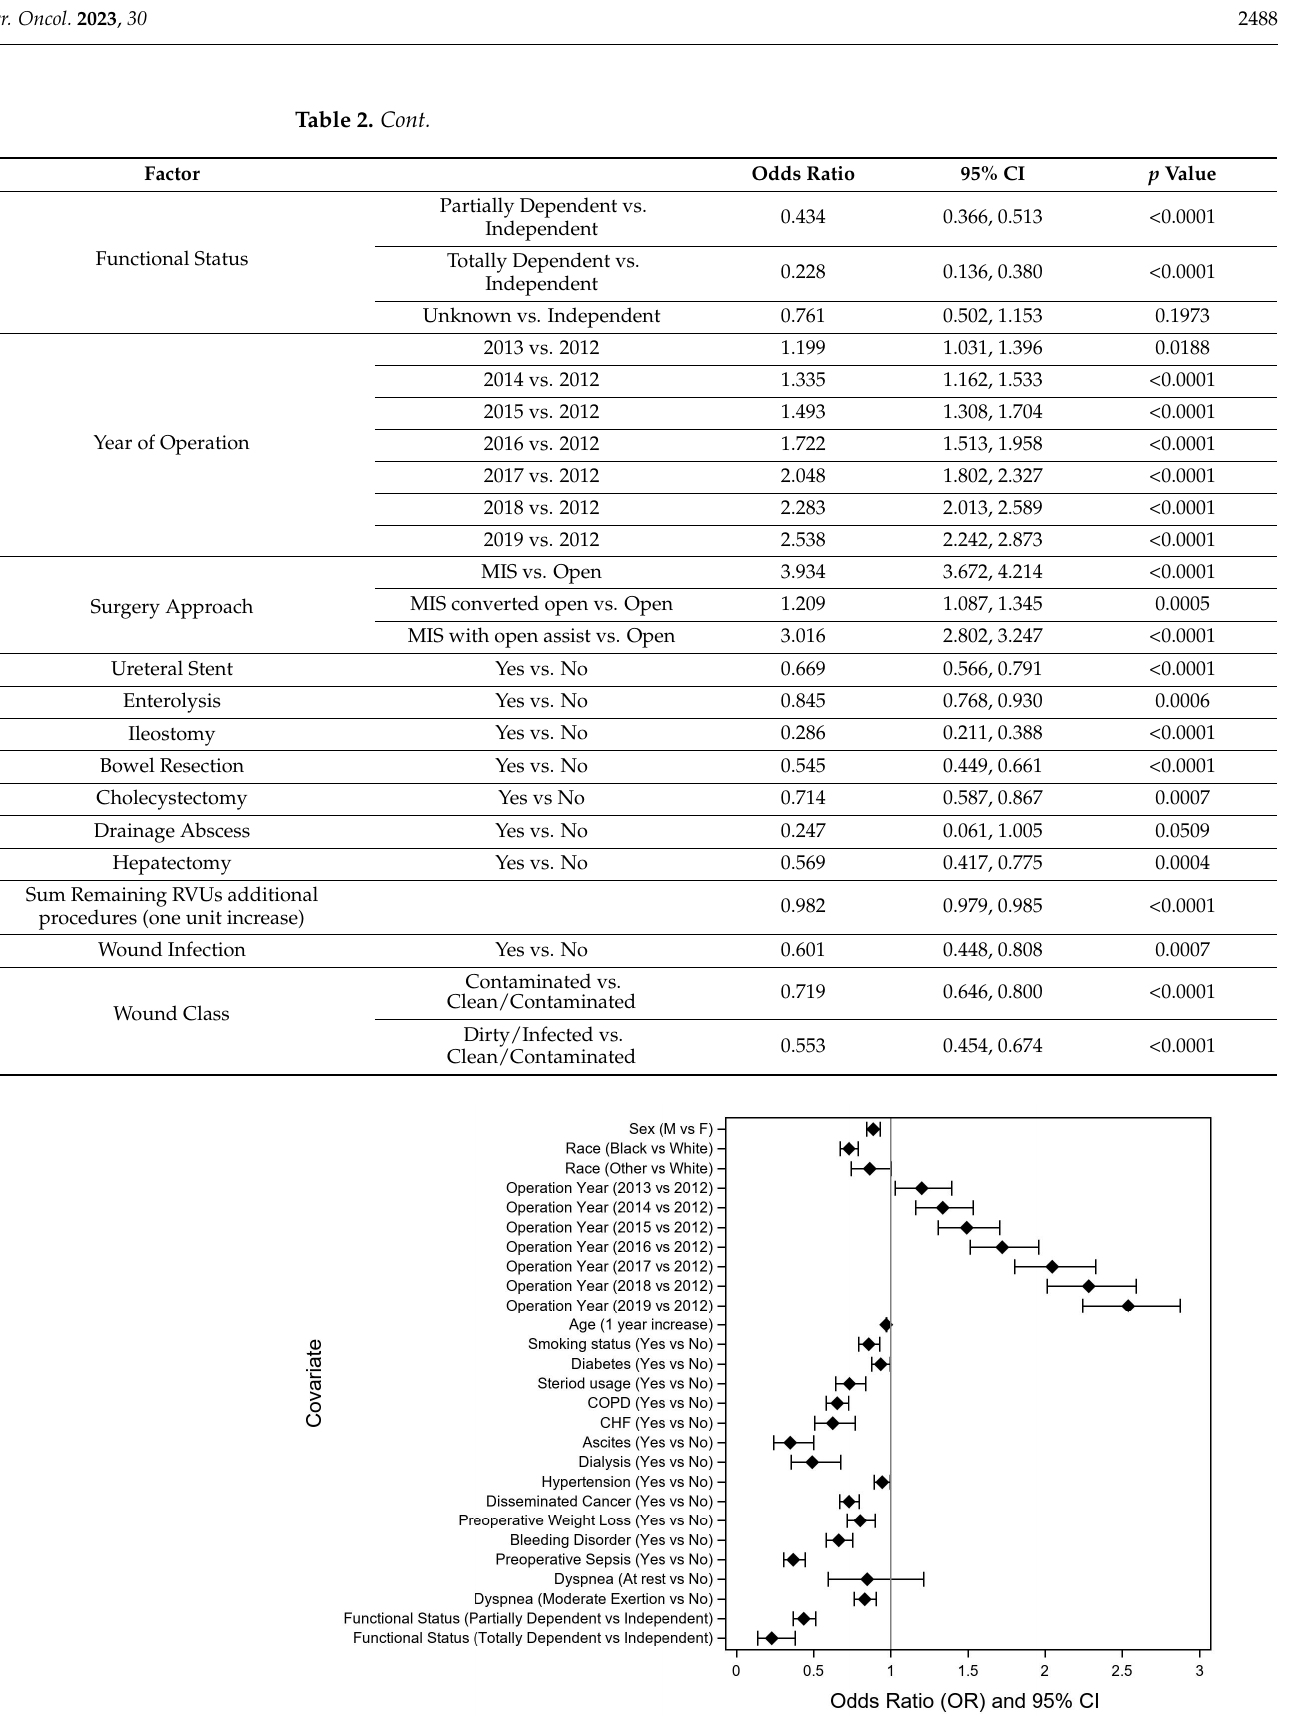
Figure 2. Impact of preoperative variables on likelihood of early discharge (odds ratio > 1) after non-emergent right colectomy for colon cancer. COPD, chronic obstructive pulmonary disease; CHF, congestive heart failure.